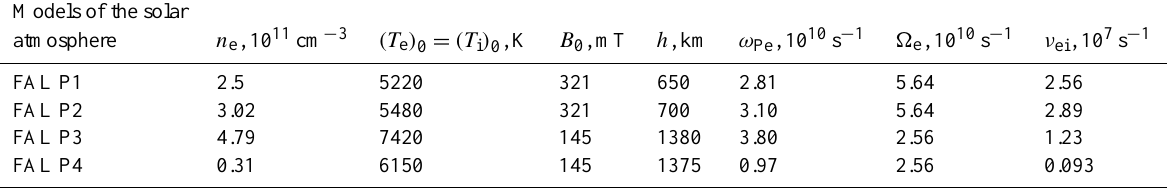
Table 2. Physical characteristics of the pre-flare plasma at the lower chromosphere of the loop’s current circuit in an active region. Models of the solar